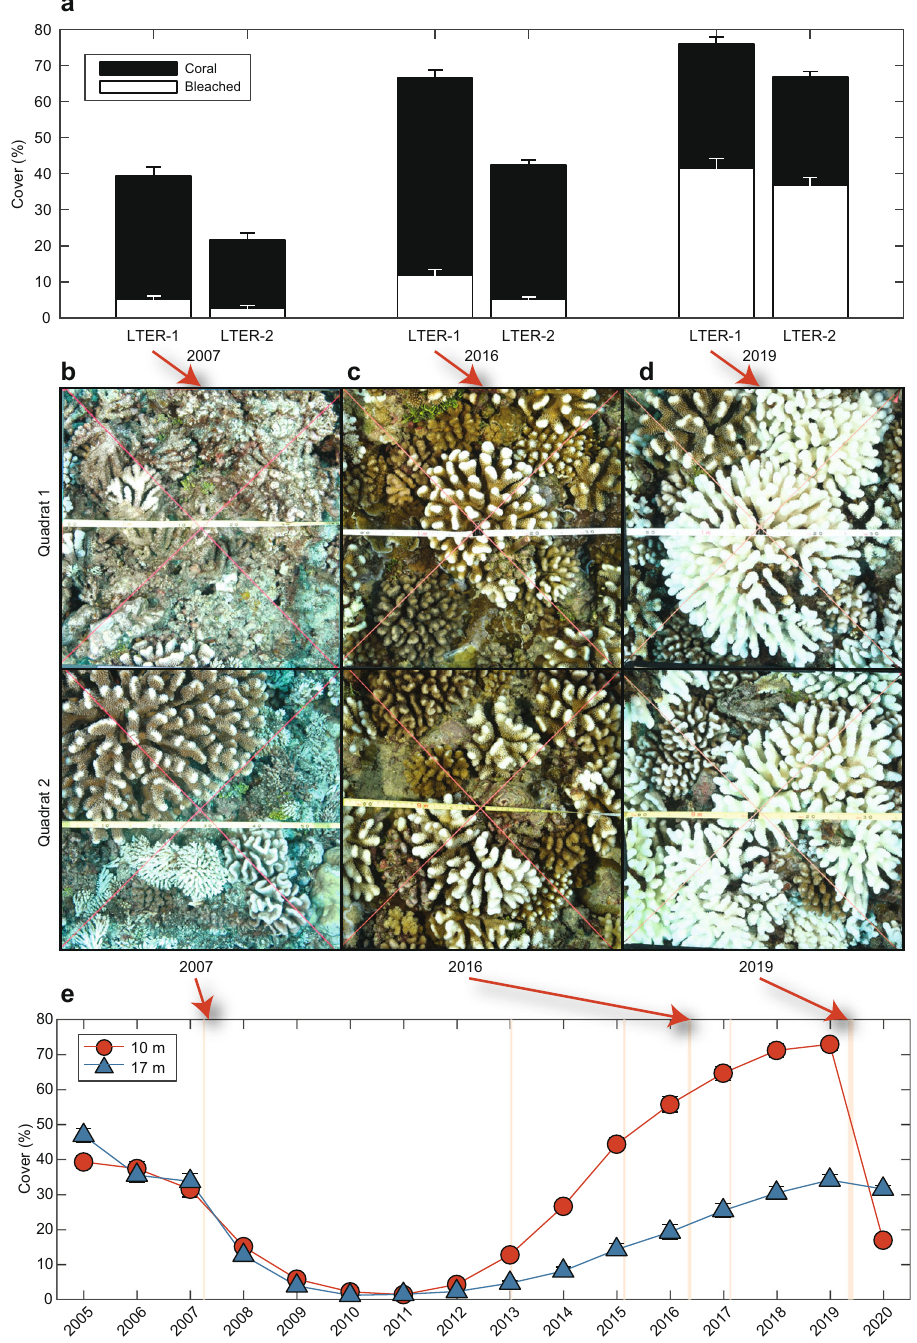
Fig. 9 | Increased prevalence of coral bleaching and subsequent mortality associatedwiththehidden2019subsurfacemarineheatwave(MHW)following almost a decade of recovery in live coral cover on Moorea ’ s north shore fore reef. Barsin a showthecover(in%area)ofcoral(black)andbleachedcoral(white) observed at10mdepthattwoLong-TermEcologicalResearch(LTER)sites(LTER-1 and LTER-2) during the 2007 (20 Apr), 2016 (10 May) and 2019 (1 May) MHWs.